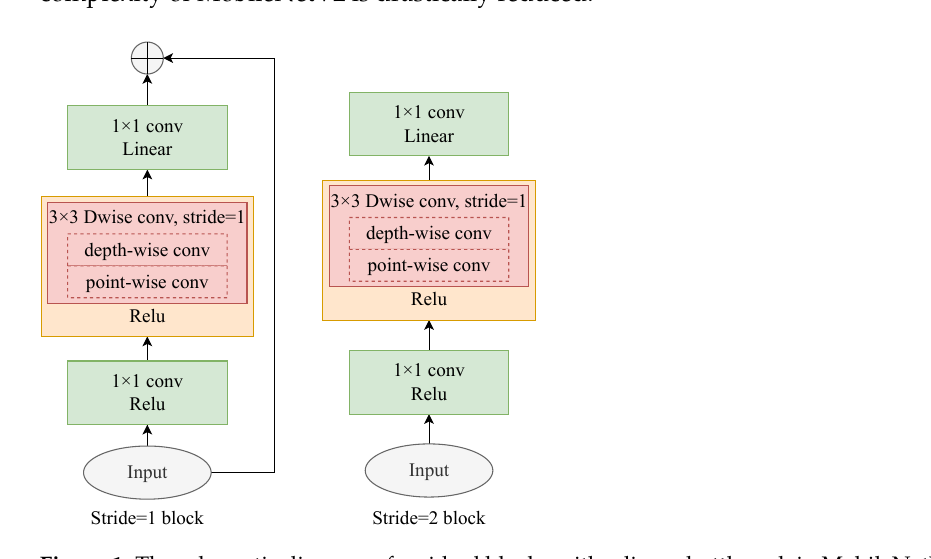
Figure 1. The schematic diagram of residual blocks with a linear bottleneck in MobileNetV2. ⊕ de- notes element-wise addition, and Dwise conv represents depth-wise separable convolution.